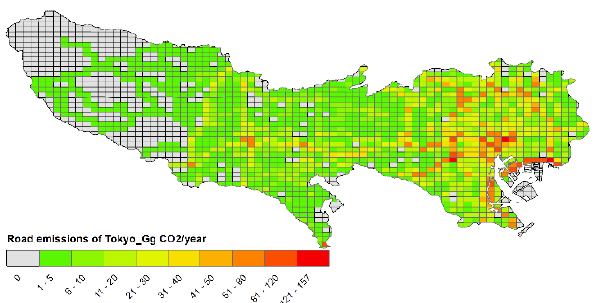
Figure 4. CO 2 emissions map with a resolution of 1 × 1 km on road traffic of Tokyo in 2015, unit: Gg CO 2 yr -1